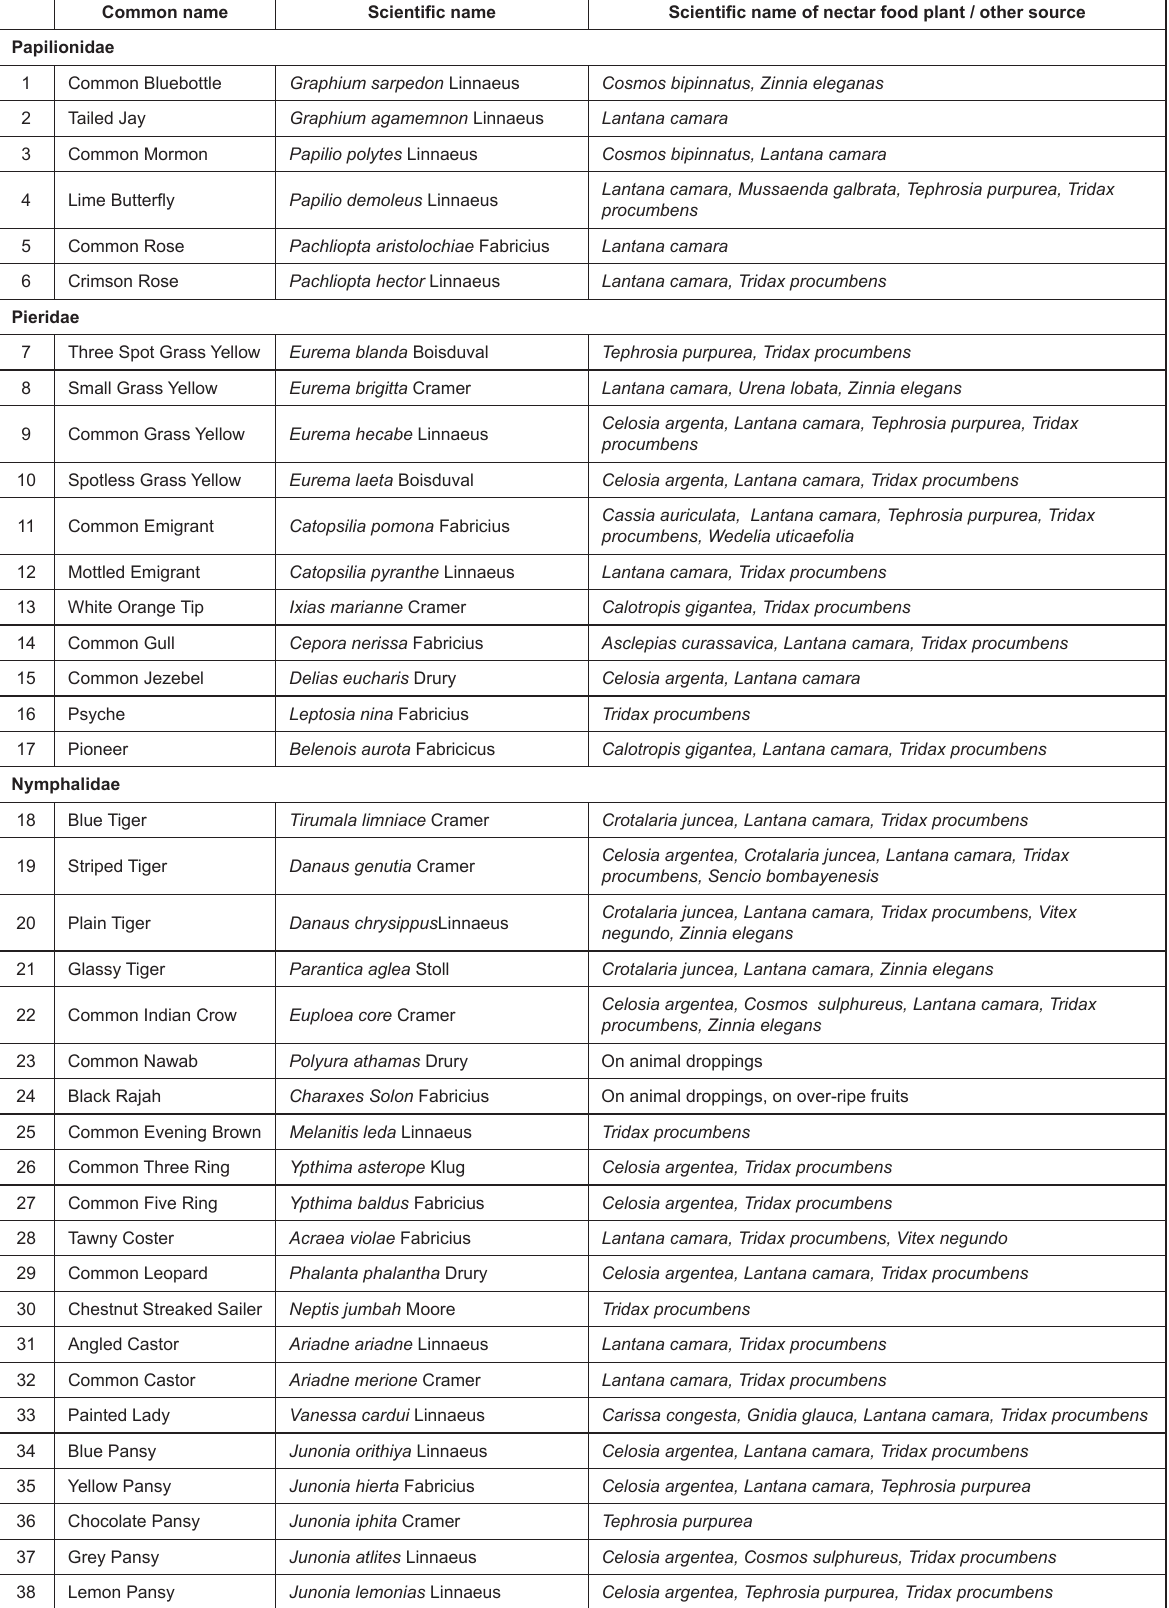
Table 4. Nectar food plants and other food sources of butterfly species observed from study area Bhor Tahsil, Pune District,